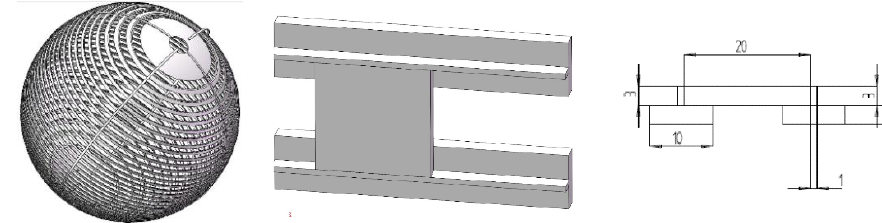
Figure 6. Modified powersphere design.